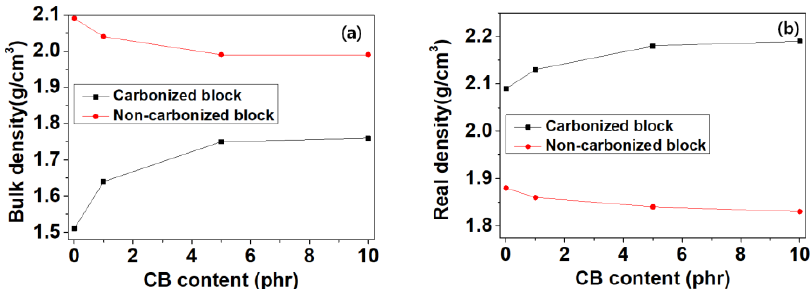
Figure 5. The density of carbon blocks according to the added CB amount: ( a ) bulk density and ( b ) real density.